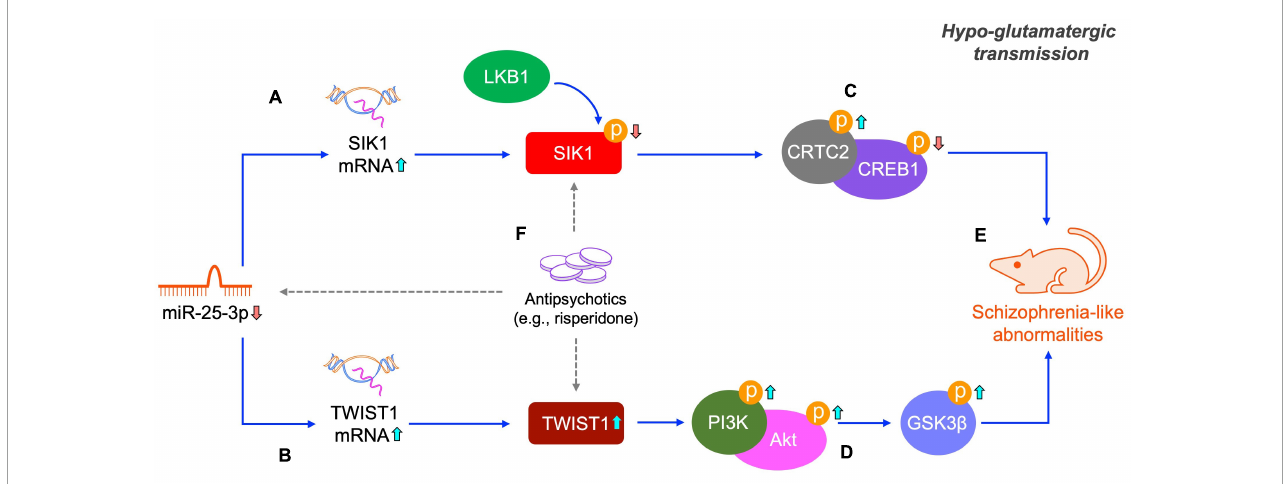
FIGURE7 Schematic of the miR-25-mediated SIK1/CRTC2/CREB1 and TWIST1/PI3K/Akt/GSK3 β signaling pathways in schizophrenia. Under a hypo-glutamatergic circumstance induced by MK-801, decreased miR-25-3p expression promotes the mRNA expression of SIK1 and TWIST1 (A,B) . Altered SIK1 activation probably caused by both miR-25-3p and LKB1 induces the inactivation of the CRTC1/CREB1 signaling cascade (C) and changed TWIST1 expression represses the PI3K/Akt/GSK3 β signaling cascade (D) , both of which eventually lead to schizophrenia-like abnormalities (E) . These two signaling pathways altered by repeated MK-801 administration can be restored by antipsychotic drugs (e.g., risperidone), however, the underly pharmacological actions of risperidone requires further elucidation (indicated by dashed arrows) (F)